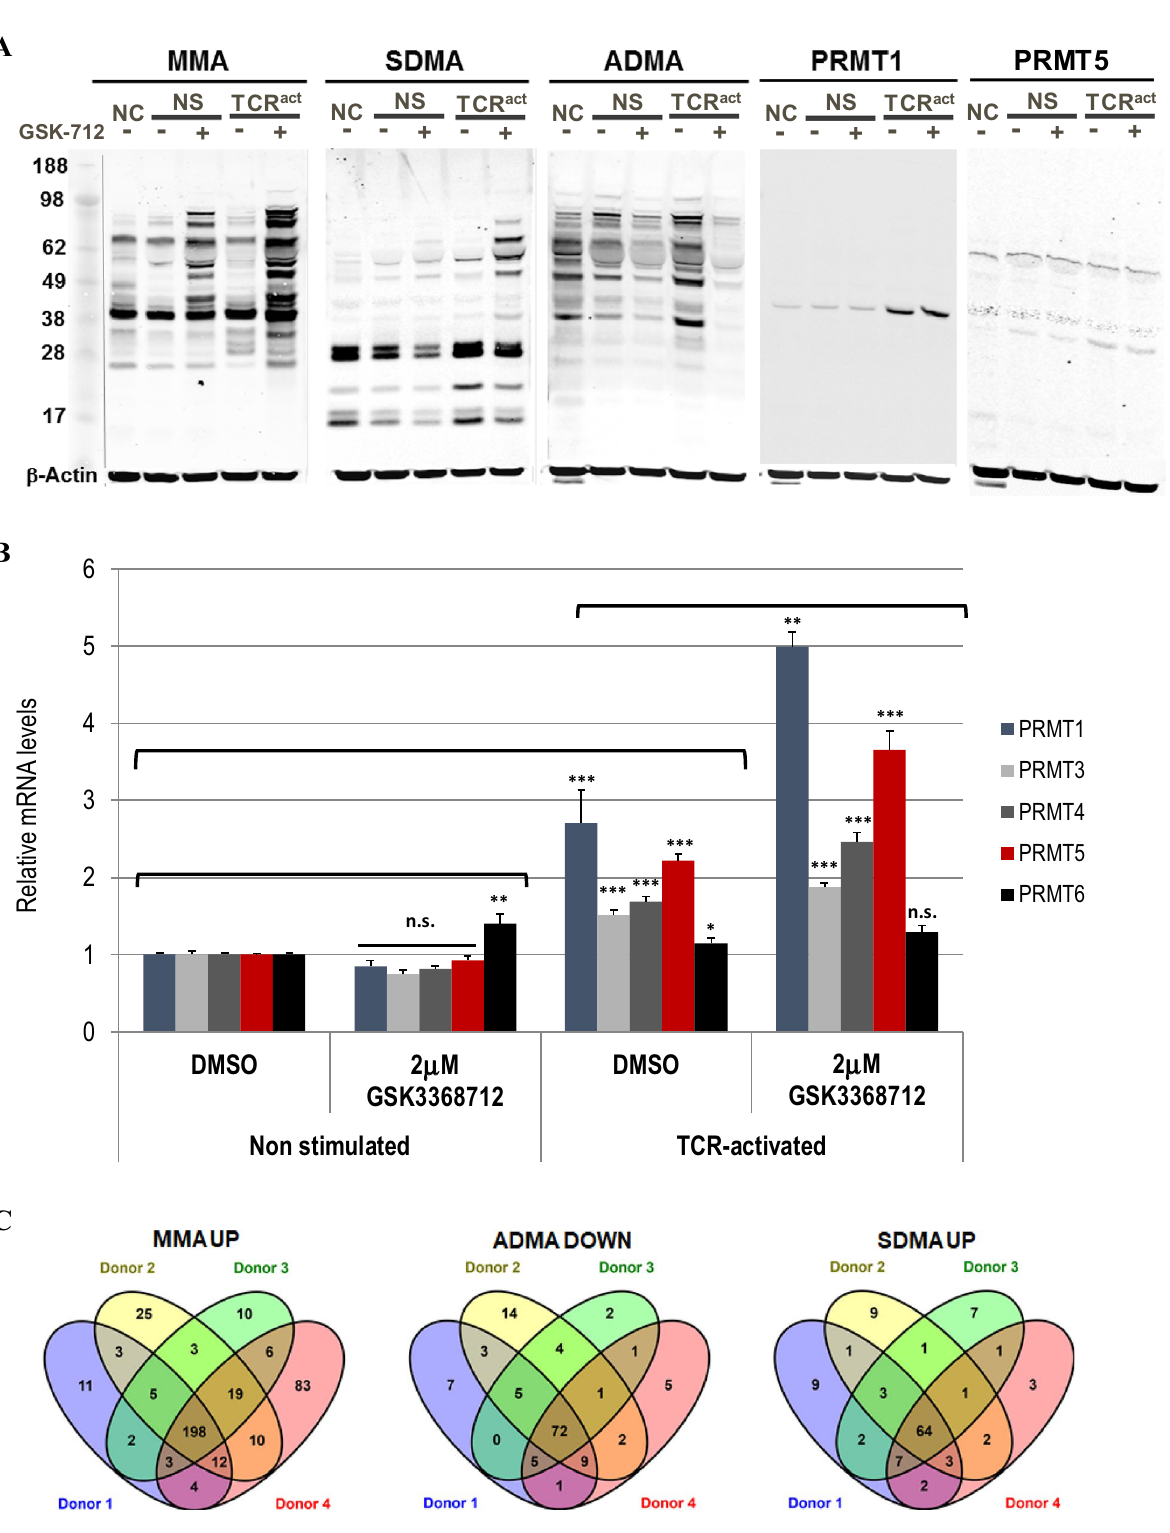
Figure 2. Effects of type I PRMT inhibition in human PBMCs. Western Blot analysis of monomethyl-arginine (MMA), symmetric dimethyl arginine (SDMA), asymmetric dimethyl arginine (ADMA), PRMT1 and PRMT5 (NC, non-cultured, NS, non-stimulated, TCR act , T Cell Receptor activated) ( A ) and RT-PCR for several PRMTs ( B ) in non-stimulated and TCR-activated human PBMCs from healthy donors treated with either DMSO or 2 µM GSK3368712 for 72 h (two-tailed Student’s t test: * p < 0.05, ** p < 0.01, *** p < 0.001; n.s., not